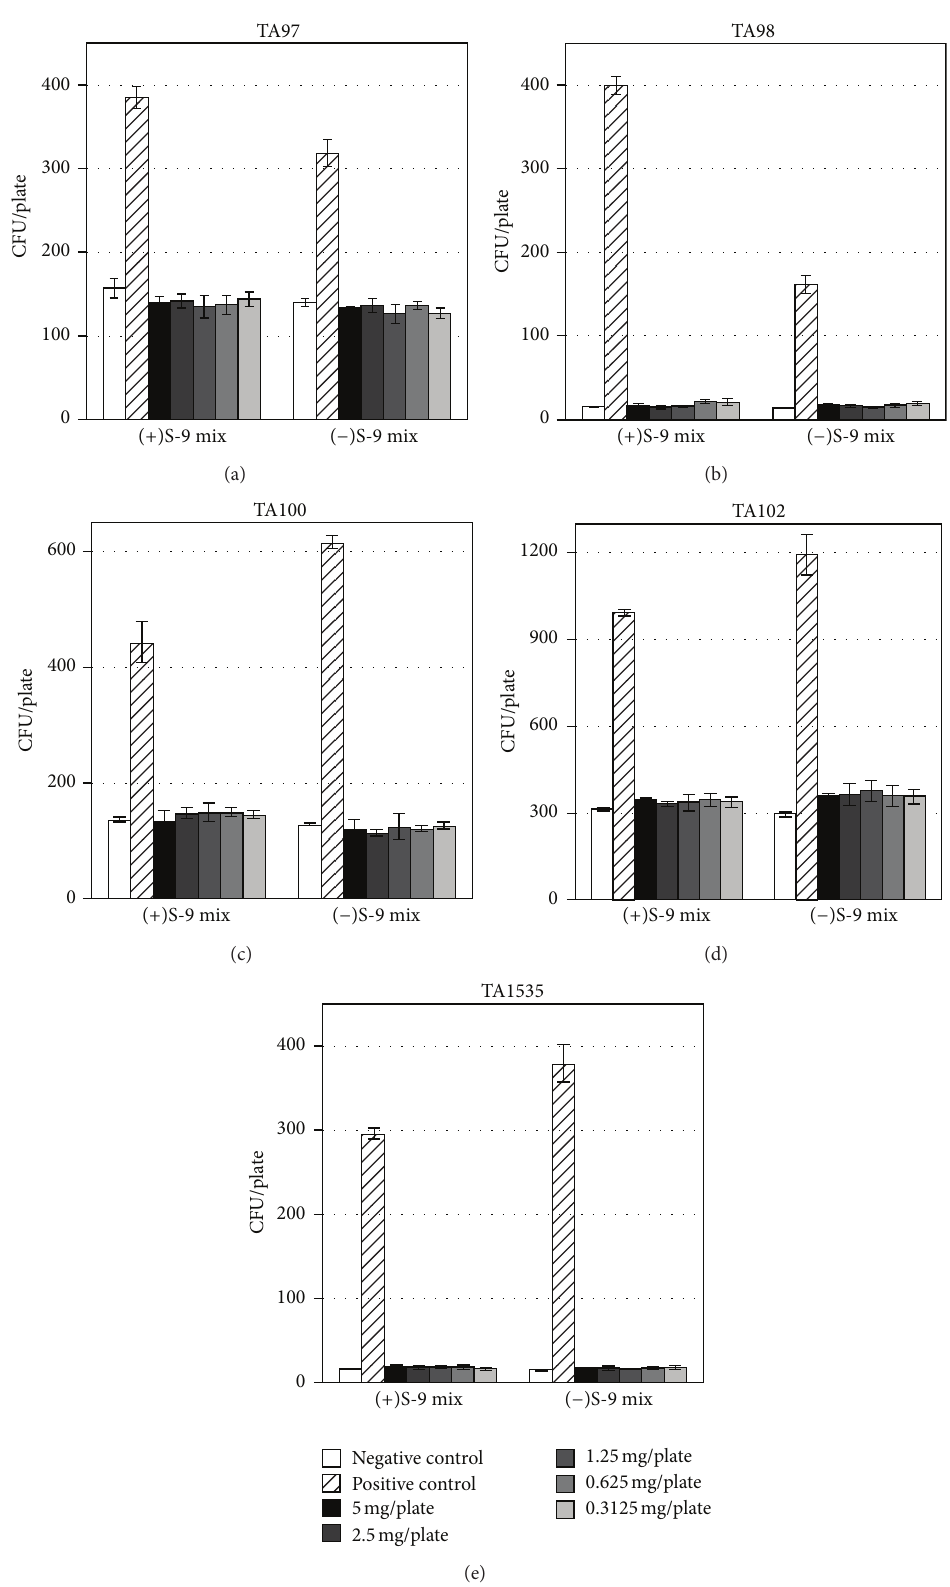
Figure 1: The multispecies probiotic mixture does not induce reverse mutation of Salmonella Typhimurium strains at dose levels between 0.3125 and 5 mg/plate. Metabolic activation of test substance is achieved by adding S9 mix. The graphs present the number of reverse mutated colonies grown on minimal agar plates (mean ± SD, 𝑛 = 3